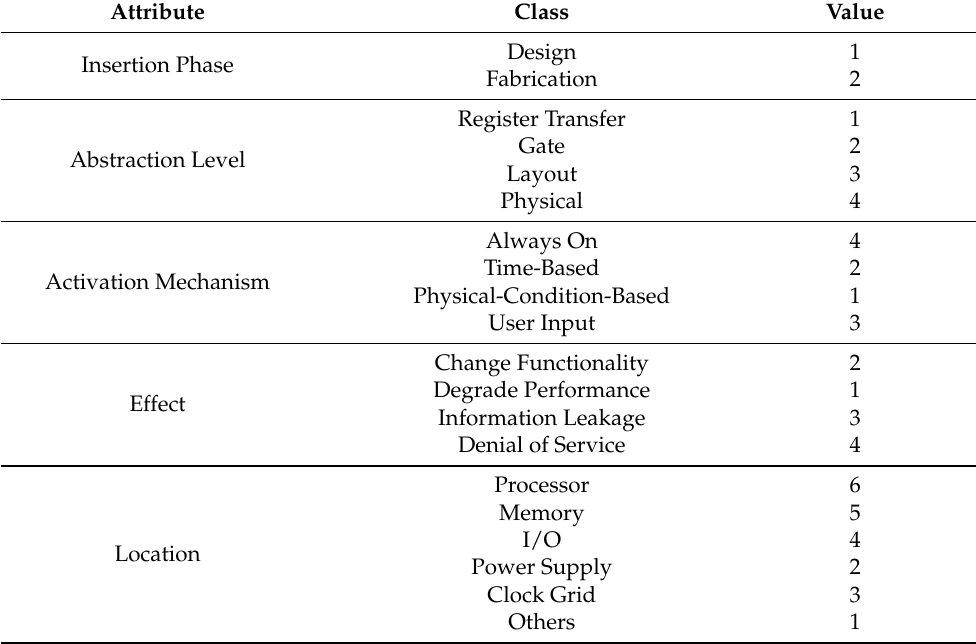
Table 1. Selected Attributes Analysis for HT